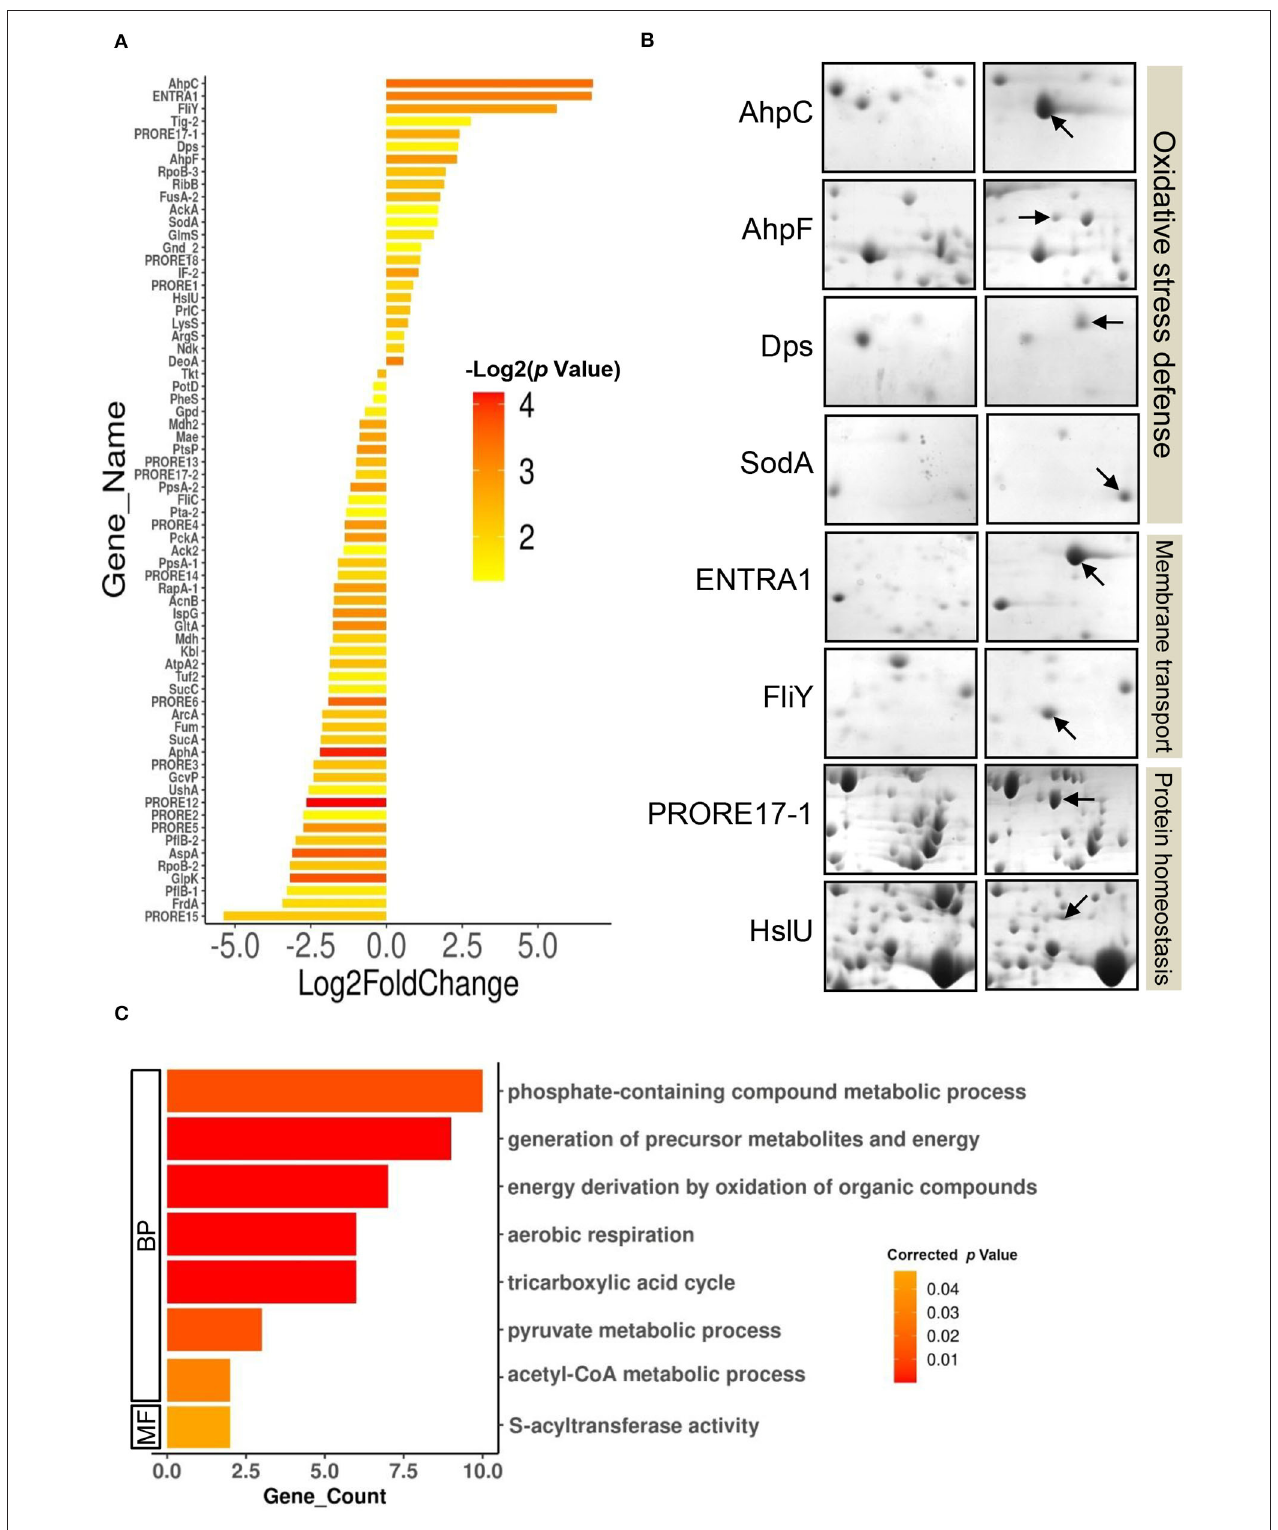
FIGURE 3 | Differentially expressed proteome of P. rettgeri exposed to 100 ppm Cd. (A) Bar plot representing the Log2 (fold change) on X -axis vs. p -value for the differentially expressed proteins (DEPs) on Y -axis. Log2 (fold change) is calculated by taking the ratio of the mean values of protein intensities from treated and control gels. The p -values plotted are calculated from the differential expression analysis using the Student’s t -test. Bars are colored according to the p -values. Protein abbreviations are detailed in Supplementary Table S2 . (B) Providencia rettgeri proteins upregulated following exposure to 100 ppm Cd. Proteins with increased abundance in Cd-treated cells, as compared to control cells, are shown by arrows. (C) GO functional classification of downregulated DEPs.